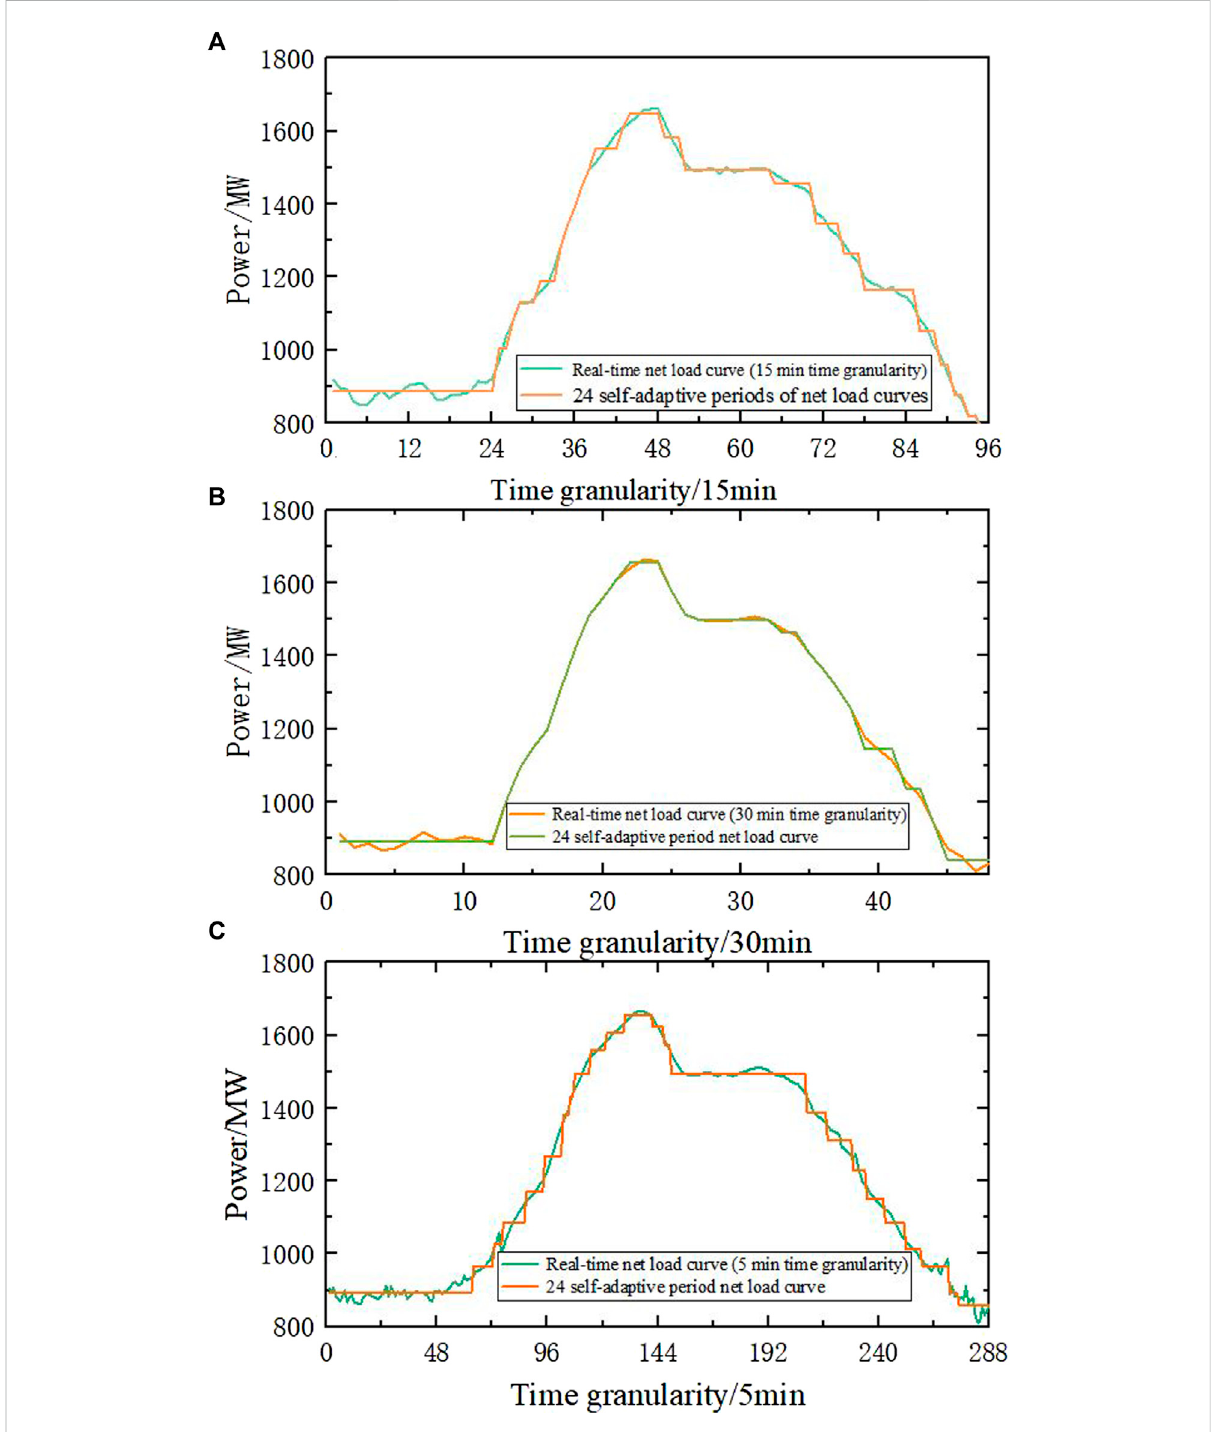
FIGURE 13 Segmentation of the net load curve under different time granularities. (A) Segmentation of net load curve at 5 min time granularity; (B) Segmentation of net load curve at 15 min time granularity; (C) Segmentation of net load curve at 30 min time